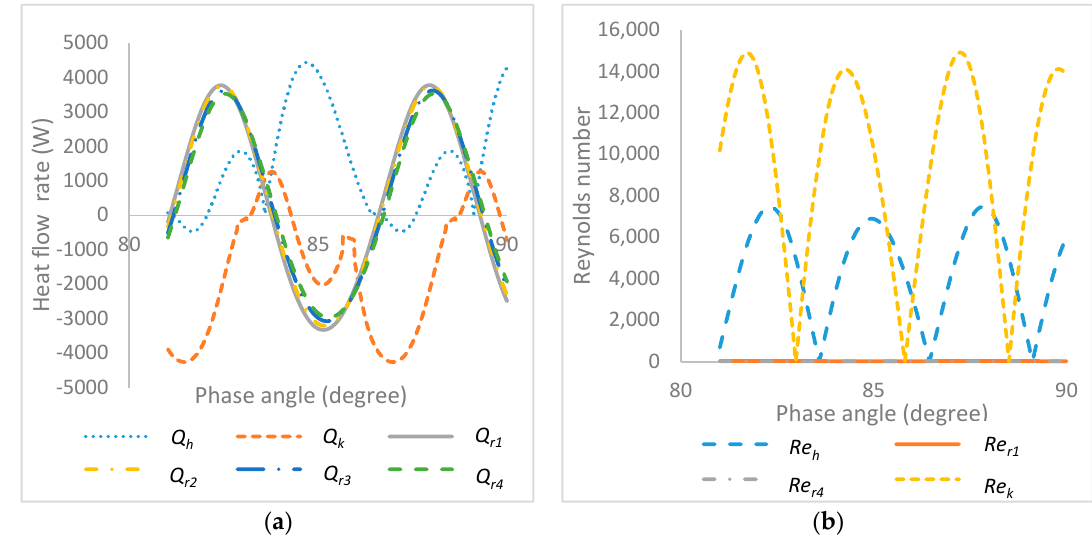
Figure 8. ( a ) Heat flow rate in the heat exchangers against phase angle; ( b ) Reynolds number of working gas flow against phase angle.